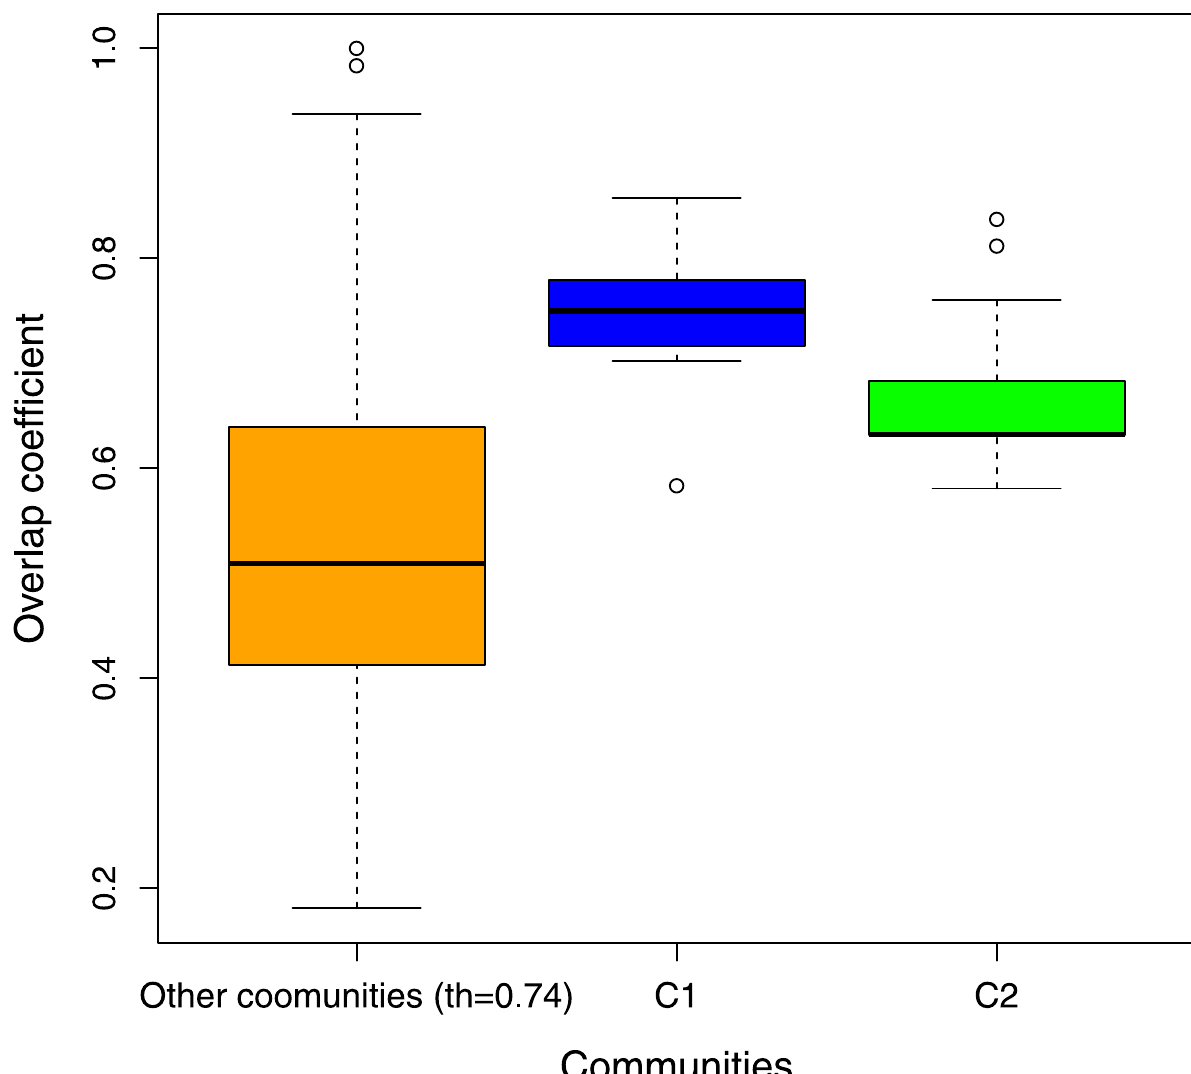
Fig 9. Overlap coefficient distributions for C 1 and C 2 communities and other communities found with th = 0.74. The overlap coefficient is computed for each bootstrap